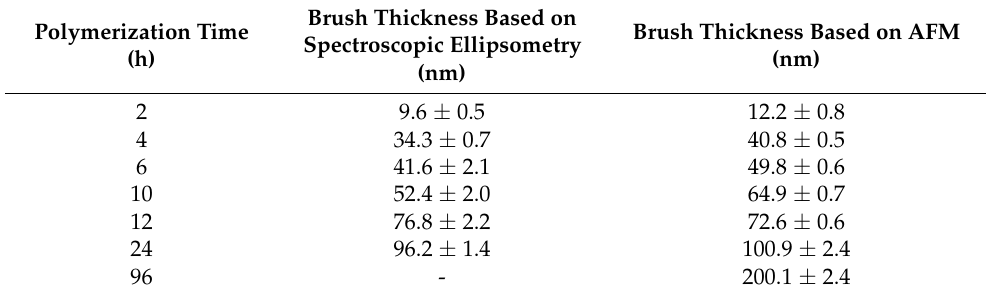
Table 3. Thicknessofpoly( St-D - alt - Ma-A